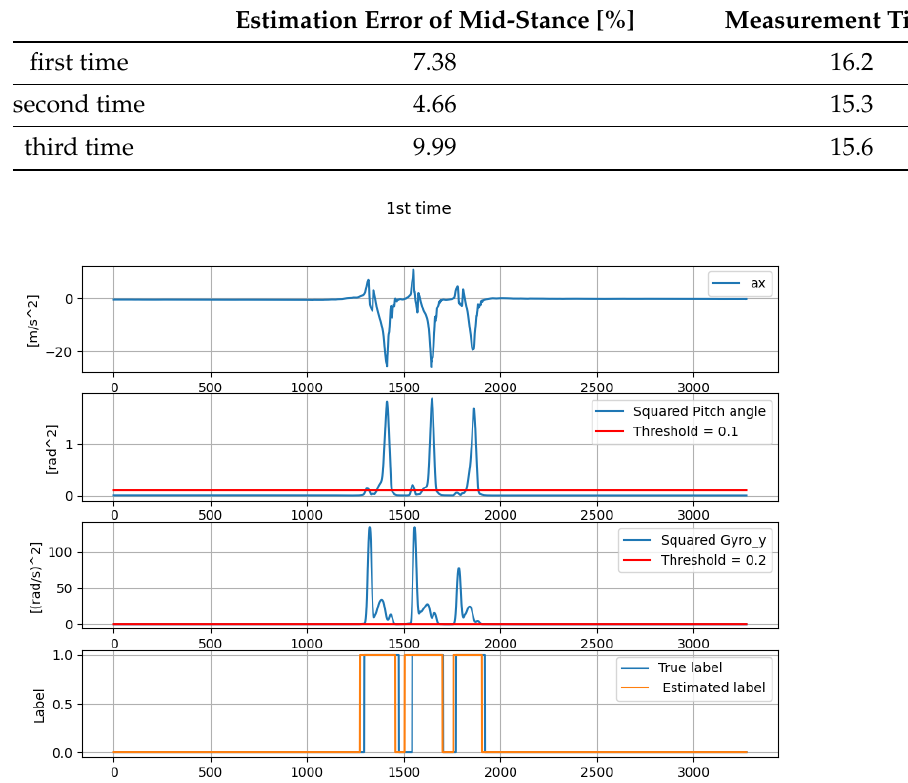
Figure 10. The wave-form of the data from the first data